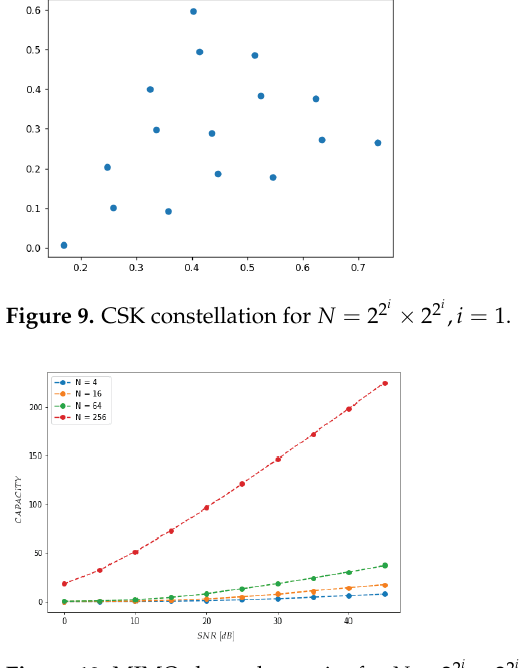
Figure 10. MIMO channel capacity for N = 2 2 i × 2 2 i ( i = 0,1,2,3 )